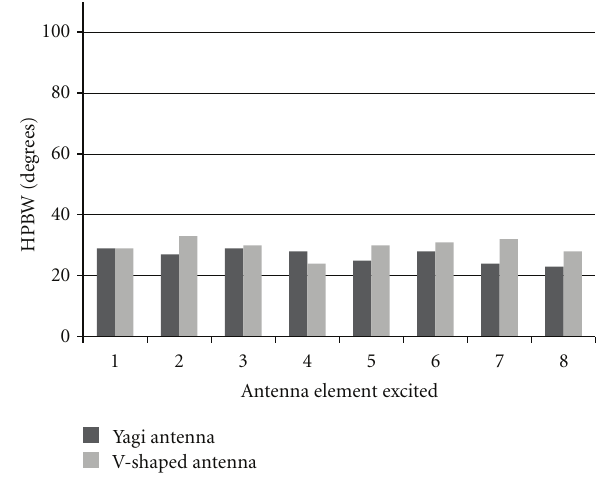
Figure 13: Measured HPBW comparison for the Yagi and the V- shaped array placed 5 cm over a ground plane operated under switched